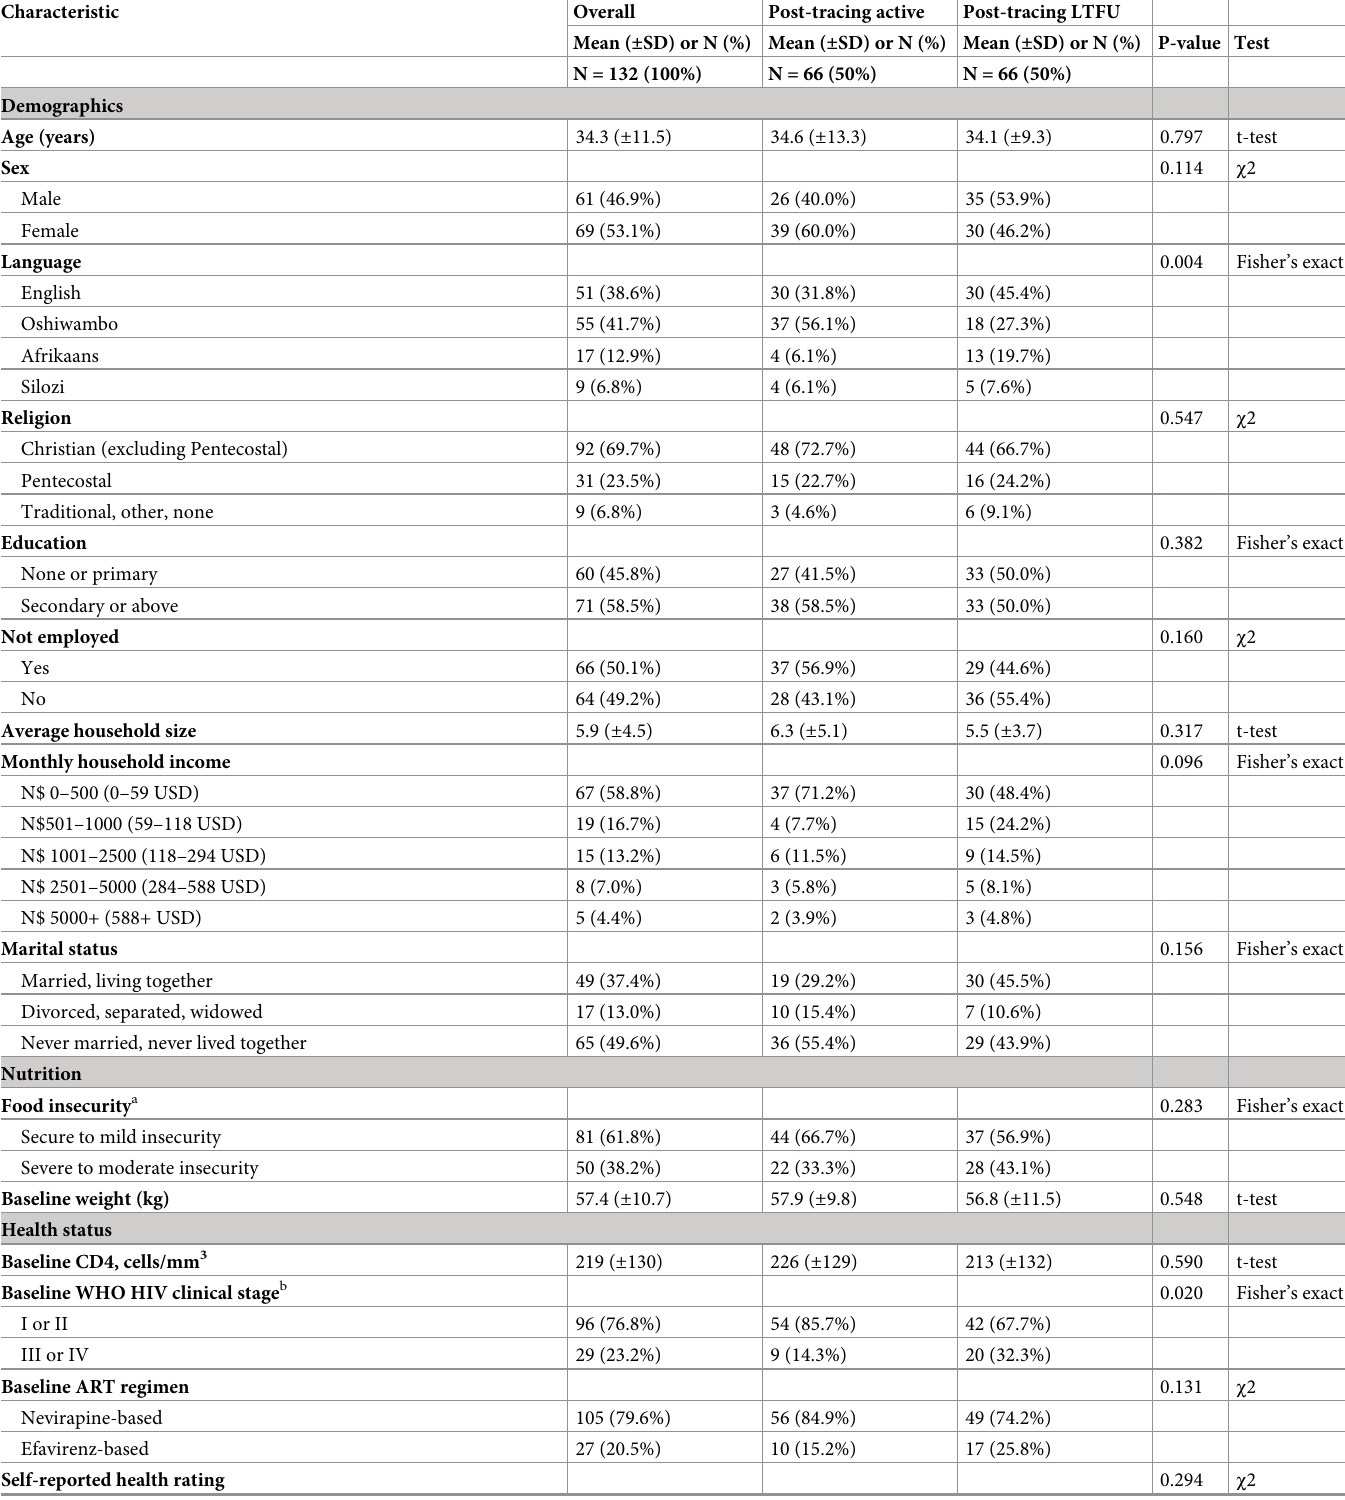
Table 3. Characteristics of patients pre-tracing LTFU and stratified into post-tracing active versus post-tracing LTFU 12 months after ART initiation.